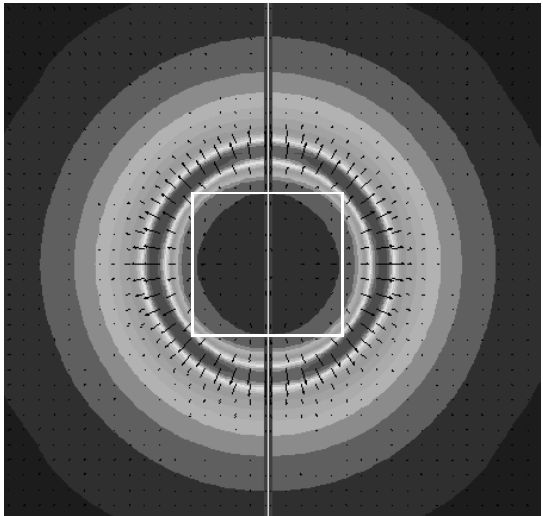
Fig. 4. Cavitation Collapse Shock.